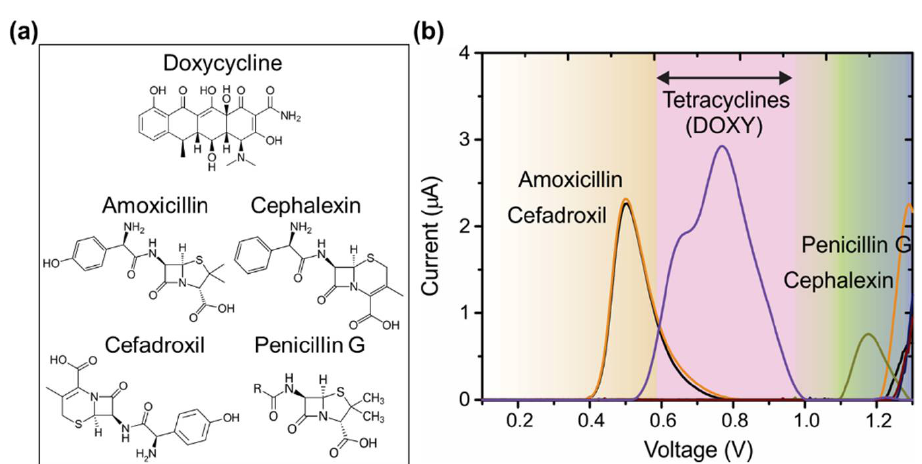
Figure 1. Comparison between ( a ) chemical structures and ( b ) peak potential range of the characteristic electrochemical fingerprints of the tetracyclines (Doxycycline, pink region) with other type of antibiotics, such as Amoxicillin and Cefadroxil (orange and grey region) or Cephalexin and Penicillin G (green and blue region). Moving average corrected square wave voltammogram using a concentration of 100 µM for each antibiotic, except for Penicillin G (1 mM).